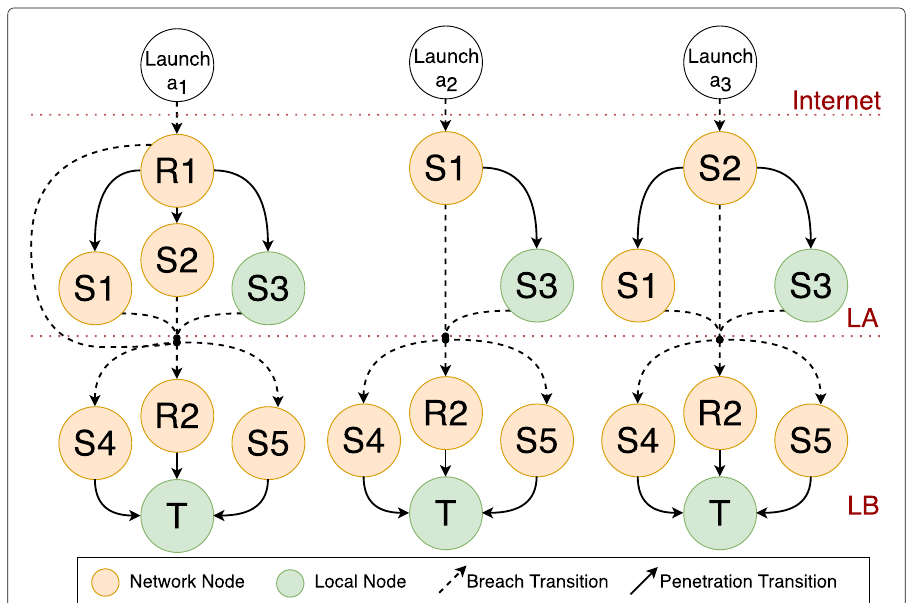
Fig. 3 Three compromise graphs corresponding to the identified attack strategies a 1 , a 2 ,and a 3